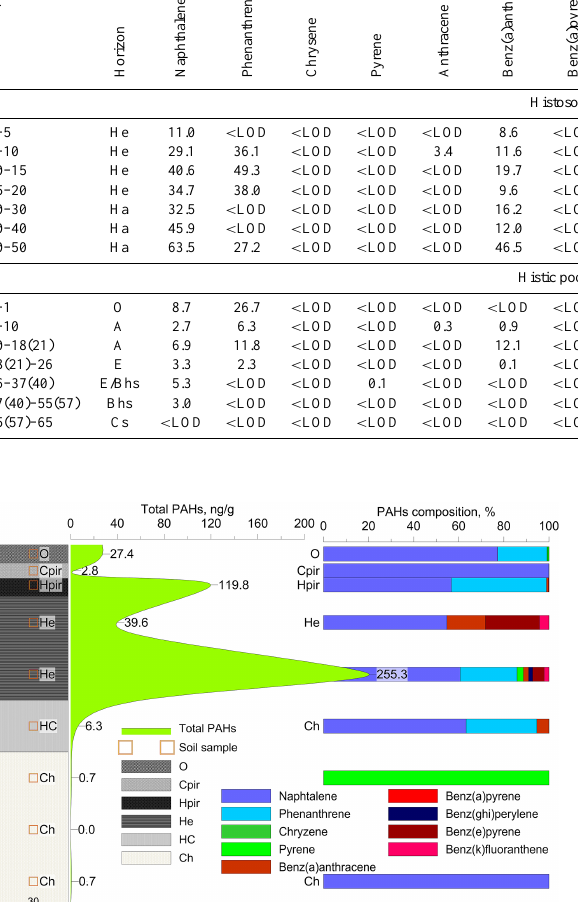
h , p t ond e z r i H o